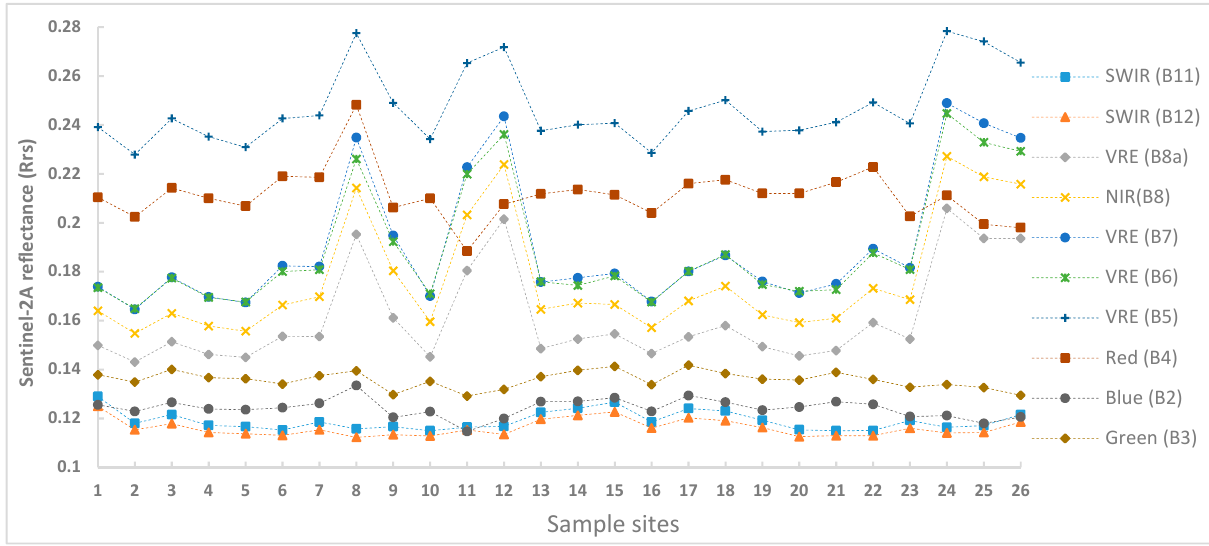
Figure 3. RS reflectance variations over sampling points across Sentinel-2 bands.